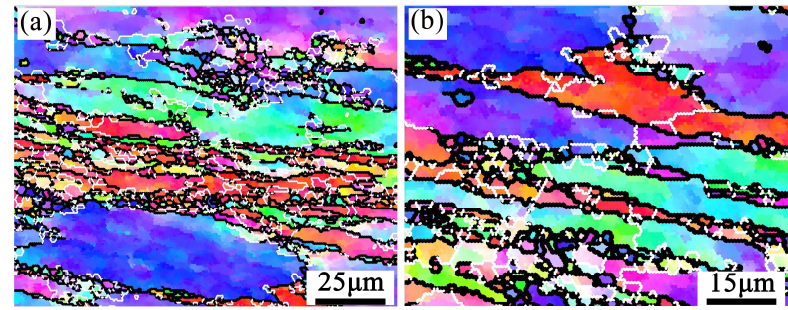
Figure 14. The enlarged images of black rectangle in Figure 13c. ( a ) Ⅰ, ( b ) Ⅱ . Table 4. The recrystallized fraction under various deformation conditions (%).